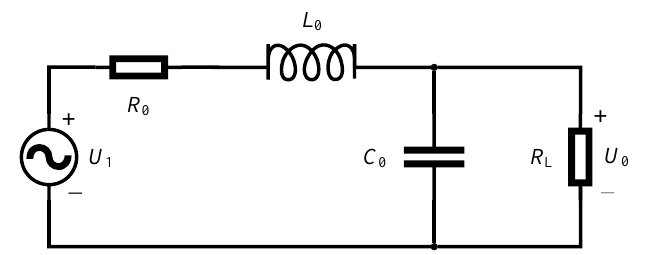
Figure 5. B-dot antenna equivalent circuit.